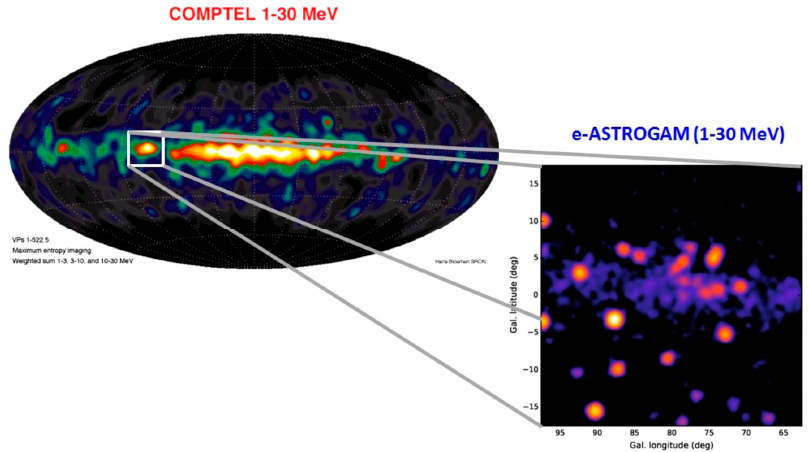
Figure 7. 1–30 MeV gamma in the sky as observed by COMPTEL in the 1990s ( upper left ) and the simulated Cygnus region in the 1–30 MeV energy region expected from e-ASTROGAM ( lower Cygnusregioninthe 1–30MeVenergyregion expectedfrome-ASTROGAM( lowerright )[151]. Reproduced right ) [151]. Reproduced with permissions from Angelis et al. [151]. with permissions from Angelis et al.